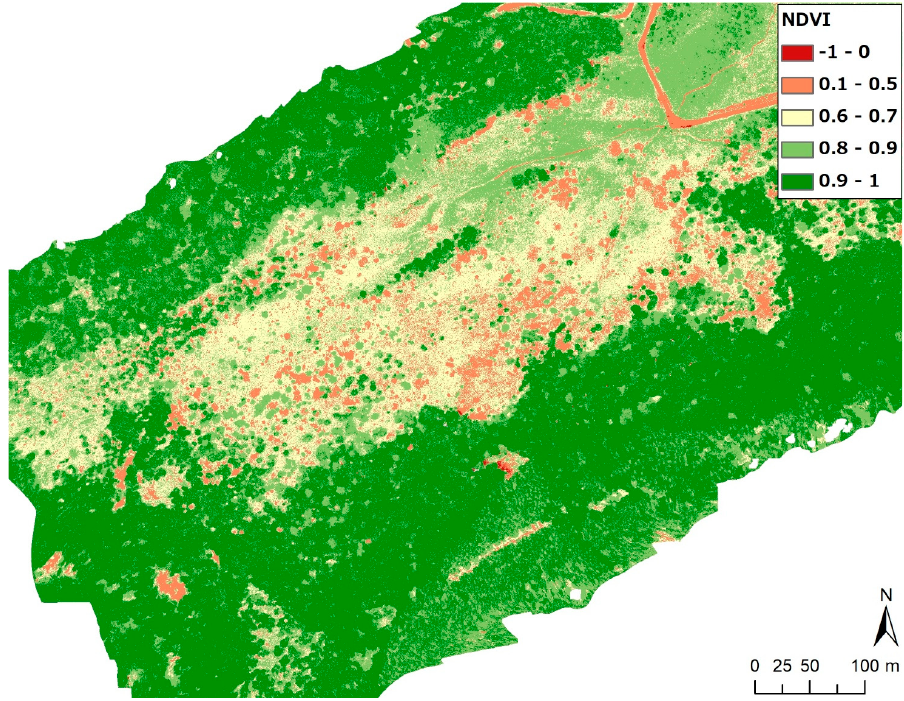
Figure 5. NDVI of the entire shooting range.